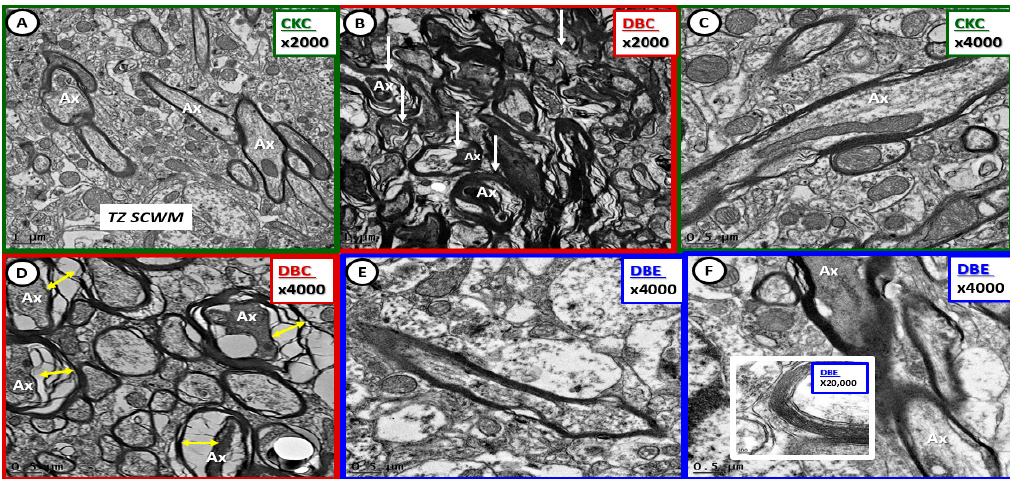
Figure 10. Diabetes-induced transitional zone subcortical white matter myelin and axonal remodeling was prevented with empagliflozin. Panels ( A ) and ( C ) demonstrate normal axon and myelin ultrastructural morphology in the transitional zone. Panels ( B ) and ( D ) depict myelin splitting, disarray, and axonal collapse, respectively (arrows and double arrows). Empagliflozin prevented the aberrant myelin and axonal remodeling (panels ( E ), ( F )). Insert in panel ( F ) depicts the intact myelin lamellar units. Magnifications 2000 × ; scale bar = 1 µ m (panels ( A ), ( B )); magnifications 4000 × ; scale bar = 0.5 µ m (panels ( C )–( F )). Magnification 20,000 × ; scale bar = 100 nm (insert panel ( F )). Ax = axon; TZ SCWM = transitional zone subcortical white matter.